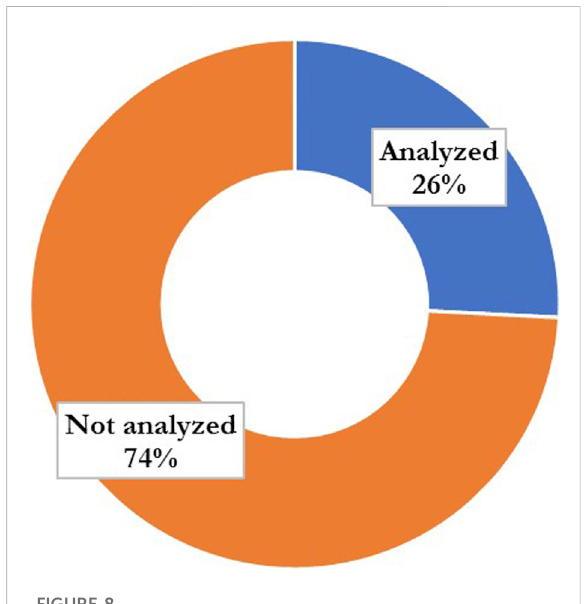
FIGURE 8 Share of studies analyzing employment implication. Source: Authors ’